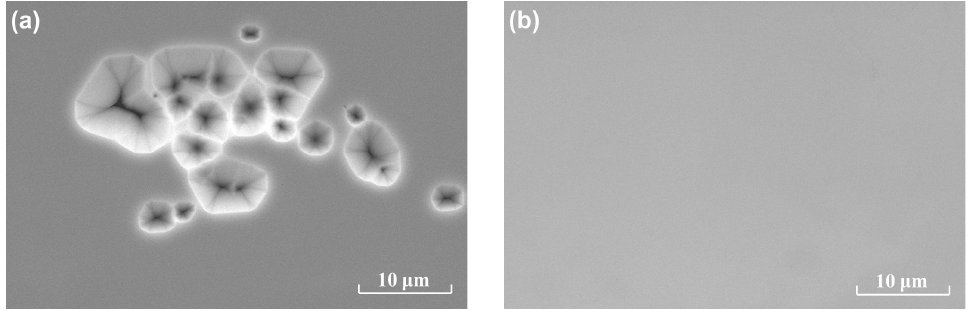
Figure 2. SEM images of ( a ) sample A and ( b ) sample B.